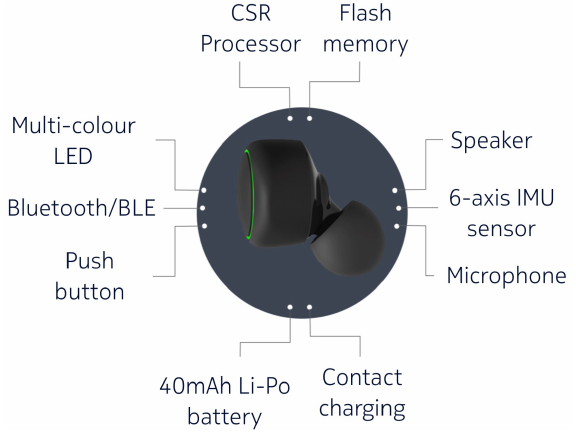
Figure 2. Components of eSense (quoted from